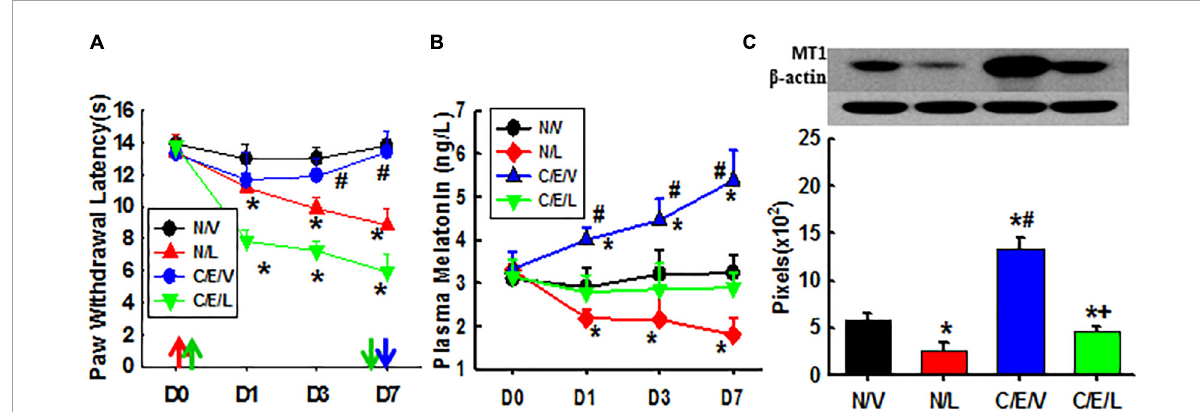
FIGURE3 Effects of luzindole on pain behavior, the melatonin level, and MT1 expression. Showing the effect of luzindole on nociceptive thresholds to thermal stimulation and on the efficacy of taVNS (A) , plasma melatonin concentration (B) , and the expression of MT1 in amygdala (Day 7; C) . D, day; the red arrow, CCI operation; the green up arrow, treatments start; the green down arrow, treatments end (Day 6); the blue arrow, sacrifice; N/V, a naive plus vehicle; N/L, naive plus luzindole; C/E/V, CCI plus a taVNS plus vehicle; C/E/L, CCI plus taVNS plus luzindole. * p < 0.05, as compared with naive or the N/V group on the same day and with the baseline of the same group; # p < 0.05, as compared with N/L and C/E/L groups; and + p < 0.05, as compared with N/L.